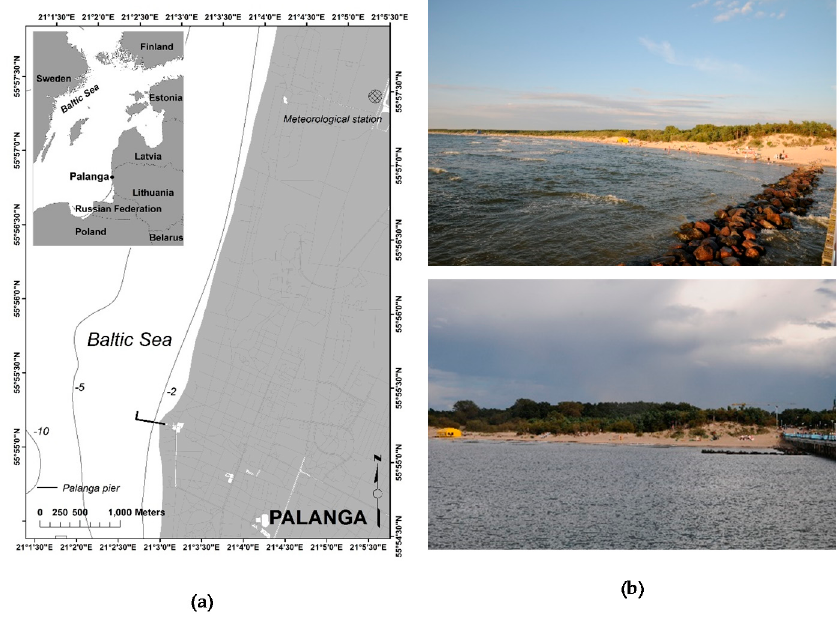
Figure 1. ( a ) Study area and ( b ) the northern side of the pier, with the adjacent groyne system (Photos: September 2018).